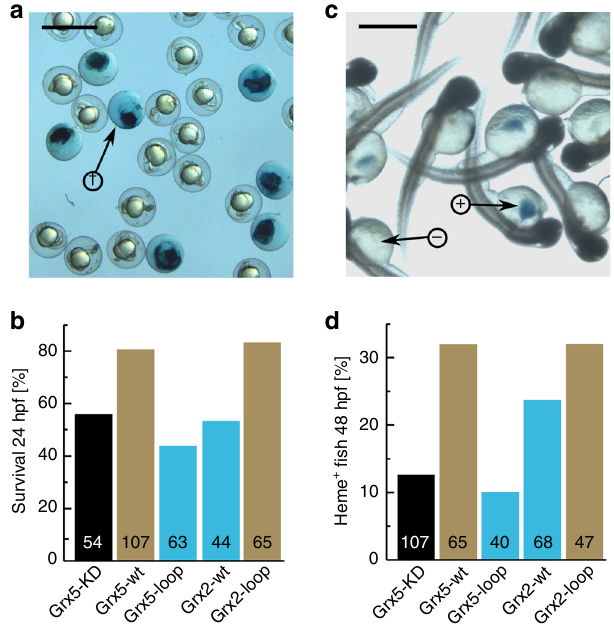
Fig. 5 Complementation of the loss of Grx5 in zebra fi sh by the engineered Grxs. a Example image and quanti fi cation b of dead (stained by methylen blue) and alive zebra fi sh embryos 24 h post fertilization (hpf). The arrow with cross in a points to a dead embryo. Heme-positive staining ( c ) and quanti fi cation ( d ) via diamino fl uorene in zebra fi sh embryos 48 hpf. The arrows in c point to heme-positive ( + ) and negative ( − ) embryos. Zebra fi sh Grx5 was knocked-down by a speci fi c morpholino (MO) and rescued with mRNA encoding human Grx5-wt, Grx5-loop, Grx2-wt, and Grx2-loop. All mRNAs contained the same standard mitochondrial target sequence. Percentage of survived embryos 24 hpf ( c ) and of heme positive embryos 48 hpf ( d ) was calculated. The bars for CGFS-type loop Grxs are depicted in brown, CxxC/S-type loop Grxs in blue. The numbers ( n ) of the analyzed (independently transfected) embryos were indicated within the bars. The scale bar in a measures 2 mm in length, the scale bar in c 0.5 mm. The black bar represents the controls, blue bars represents the proteins with the CxxC/S-type loop, brown bars proteins with the CGFS-type loop. Source data are provided as a Source data fi